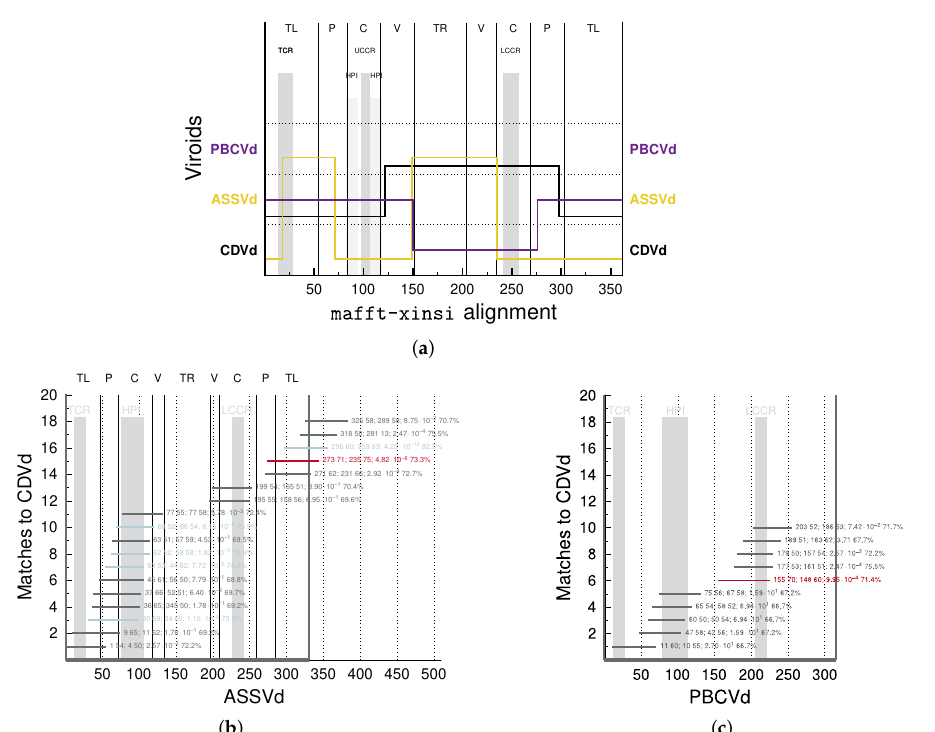
Figure 4. Similarity of CDVd with ASSVd and PBCVd. ( a ): JA LI output with a seed alignment of CDVd, ASSVd, and PBCVd. The seed alignment of the three consensus sequences was produced with MAFFT X-INS- I . Horizontal lines in the graph show which parts of the candidate sequence were aligned by JA LI to which sequence of the MAFFT alignment; vertical lines show jumps between two sequences. Line color coincides with color of viroid names. Domains of ASSVd are given at the top; domain borders are marked by black vertical lines. Motif regions are marked by vertical gray bars. For parameters used by JA LI , see Material & Methods. ( b , c ): Graphical VMATCH output. Horizontal lines mark sequence stretches of high similarity between query—PBCVd ( c ) and ASSVd ( b ), respectively— and CDVd. Red lines denote stretches of length 70 nts; blue lines denote stretches with expect ≥ value E < 10 − 3 . The numbers right of match lines are position and length of subject given on x axis, position and length of query given on y axis, expect value, and PSI. In ( b ), the ASSVd sequence was doubled to allow for matches across the unit-length circle. For parameters used by VMATCH , see Material & Methods. Domain borders of ASSVd [13] are marked by black lines; vertical gray bars mark TCR (Figure S20b), LCCR (Figure S24), UCCR, and HPI (Figure S23) of